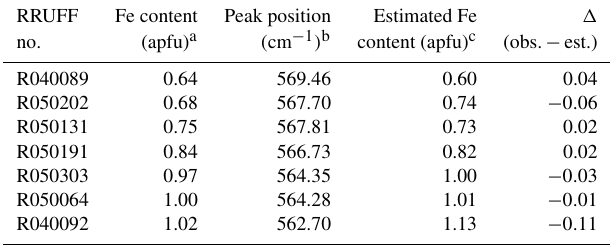
Table 7. Comparison between the Fe contents derived from EPMA as well as from the ω 570 (x) dependence proposed in this study, us- ing data for Al–Fe 3 + epidote provided in the RRUFF